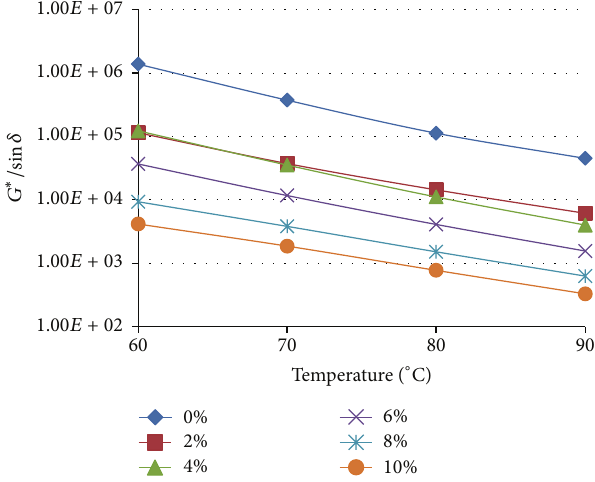
Figure8:Thevariationoftheruttingparameter( 𝐺 ∗ / sin 𝛿 )ofWCO modified TLAwith increasing temperatureat afrequency of 1.59Hz.